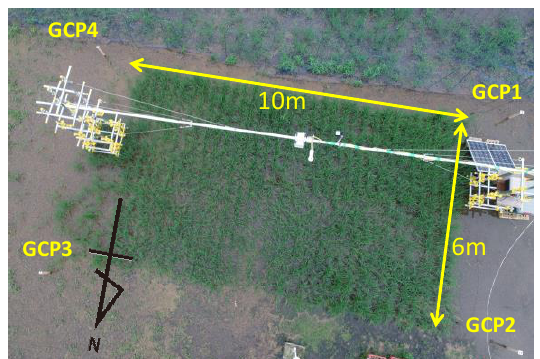
Figure 1. Study site and observational